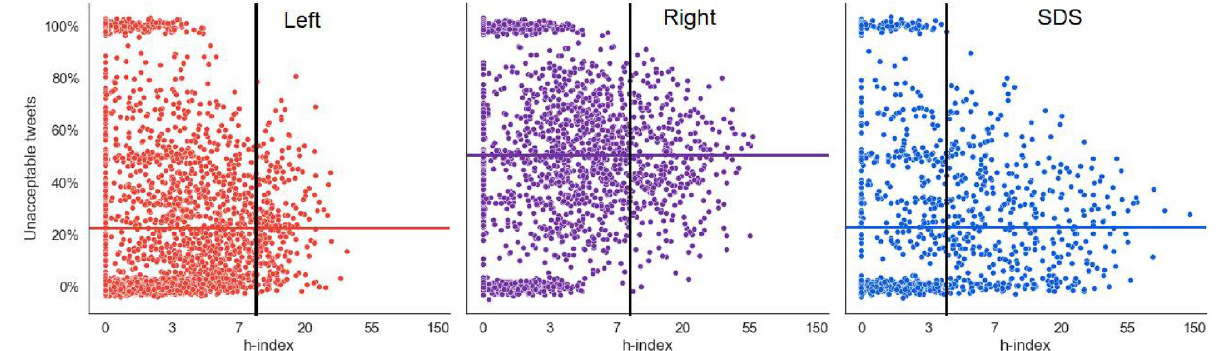
Fig 6. Scatter plot of the three major communities at the last timepoint, t = 132. Each point represents a Twitter user, with its retweet h-index and a fraction of unacceptable tweets posted. Horizontal lines show the average fraction of unacceptable tweets per community. Vertical bars delimit the low influence from the high influence Twitter users. For the most influential users, with an h-index right of the vertical bar, the user types are determined (see Table 8).